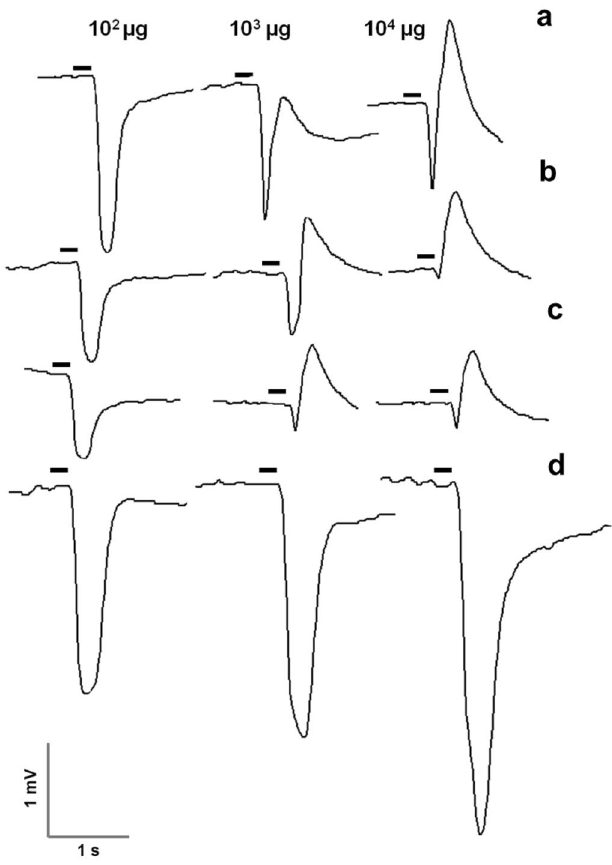
Figure 3. Representative EAG traces of S. littoralis males in response to 10 2 –10 4 µg of thyme oil ( a ), carvacrol ( b ), thymol ( c ), and p -cymene ( d ). Horizontal bars over traces indicate duration of the puffed